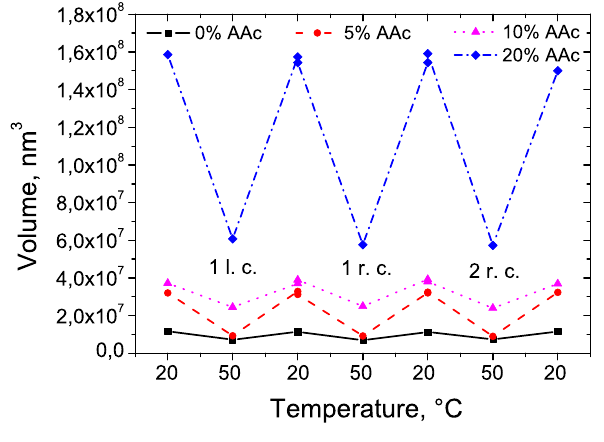
Figure 6. Temperature dependence of volume of microgel particles with 0% (squares), 5% (circles), 10% (triangles) and 20% (rhombs) AAc content deposited on Si/Au measured by SFM in one long cycle (l.c.) and in two reswelling cycles